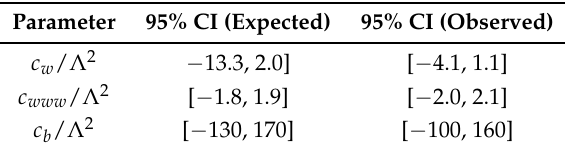
Figure 6. Distributions of discriminant observables in the anomalous couplings searches. The invariant mass of the three lepton plus the missing transverse momentum system, representing the WZ invariant mass under the assumption that the momentum of the neutrino from the W boson decay is the same as the missing transverse momentum as described in Ref. [24], is shown on the left and the transverse mass of the same configuration is shown on the right. The dashed lines represent the total yields that would be expected from the sum of the SM processes with the total WZ yields modified according to their correspondence to the given values of the associated anomalous coupling parameters. The SM prediction for the WZ process is obtained from the aTGC simulated sample with the anomalous couplings set to 0 [24]. Table 1. Expected and observed 1-D confidence intervals at 95% confidence level for each of the considered anomalous coupling parameters